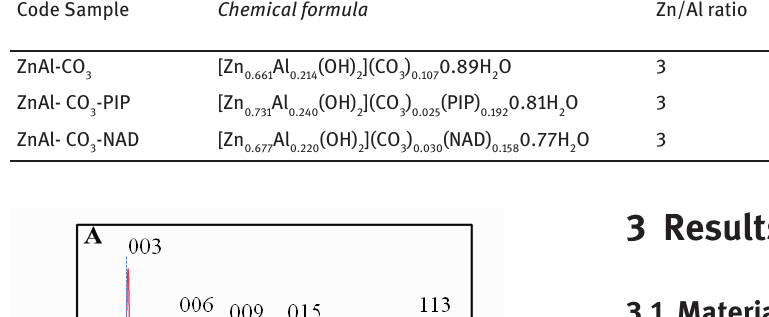
Table 1: Chemical composition of hybrid LDH samples. Code Sample